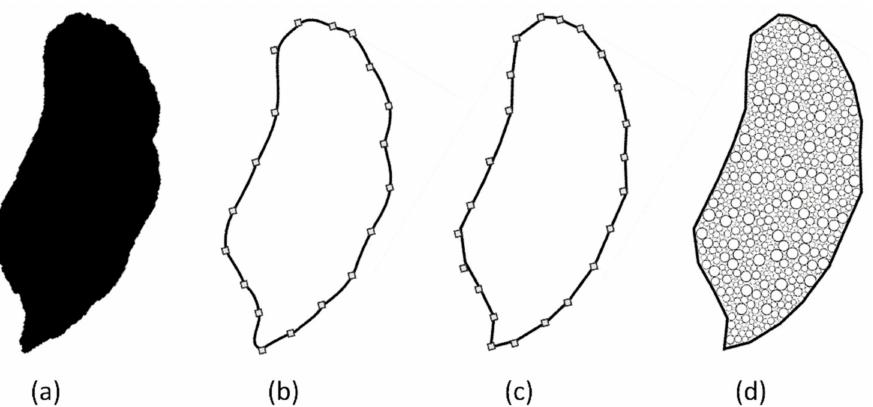
Figure 10. Procedure of creating a packing of discrete elements inside an outlining polygon of a shadow image of a real particle: ( a ) Shadow image of a real particle exported from the HAVER CPA; ( b ) Outlining B é zier spline generated with image processing methods; ( c ) Polygonalized outline; ( d ) Final packing of discrete elements in the range of 0.1 mm to 0.5 mm inside the polygonal outline. With this approach, we created packings of 67 individual particles with two